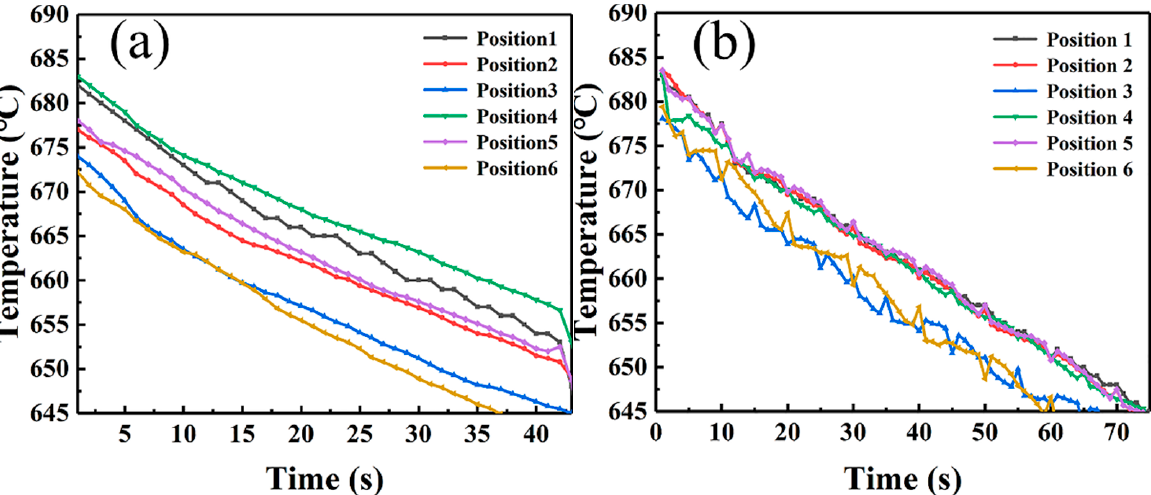
Figure 10. Cooling curves of temperature with time under different conditions: ( a ) Without ESMT; ( b ) With ESMT.